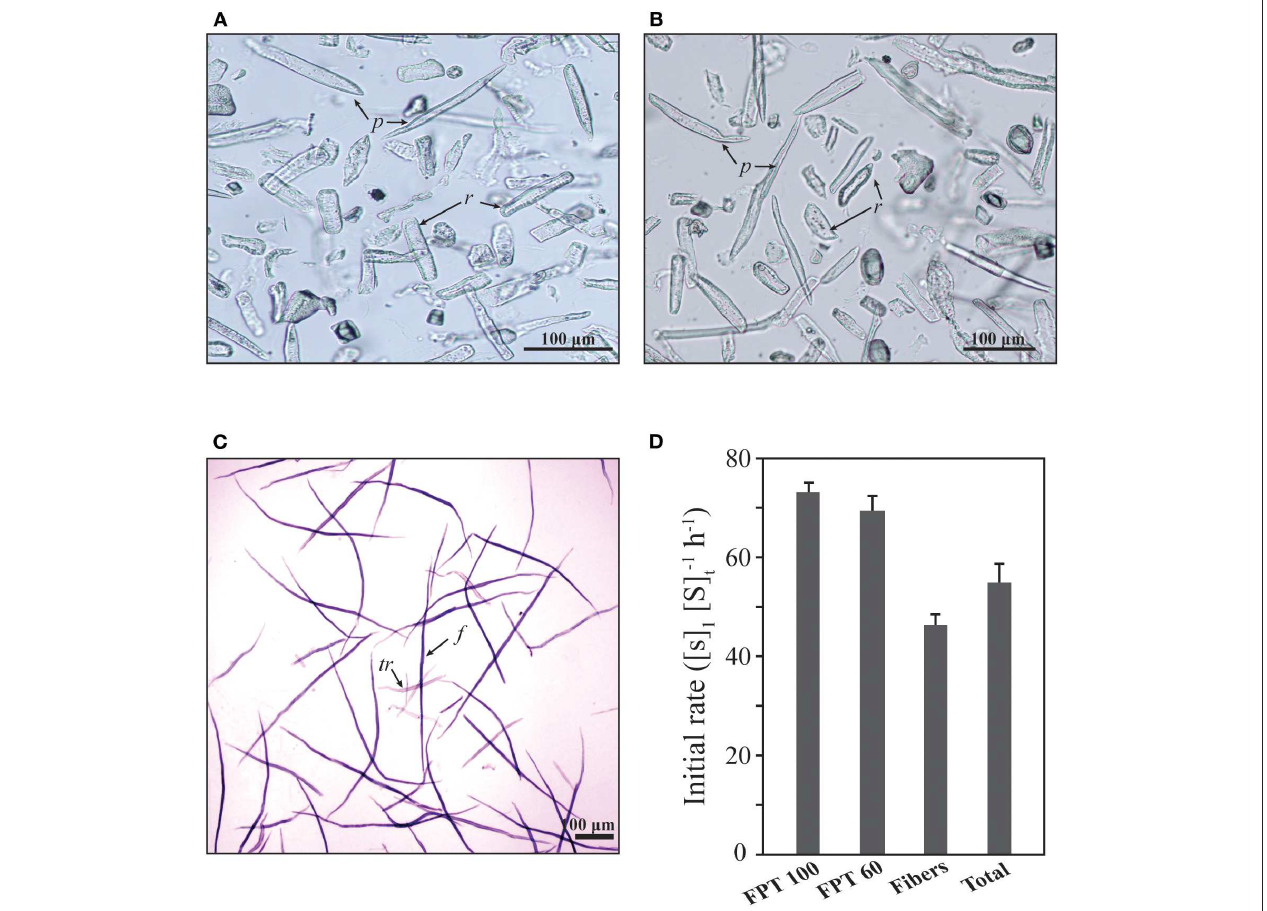
FIGURE 5 | Initial rates of anatomical tissues isolated from oak ( Q. acutissima ). (A) Fractions passing through the 100 mesh filter (FPT 100). (B) Fractions passing through the 60 mesh filter (FPT 60). (C) Remainder on the 60 mesh filter (including wood fibers, tracheids, and vessel elements). f , wood fibers; tr , tracheid fibers; p , axial parenchyma cells; r , ray parenchyma cells. (D) Enzymatic hydrolysis was performed in a 20mM citrate buffer (pH 5.0) containing 15 FPU cellulase (100 µ L mL − 1 ) at 50 ◦ C for 1h, [S] 1 . [S] t represents the total concentration of soluble sugars released from the solid substrate.